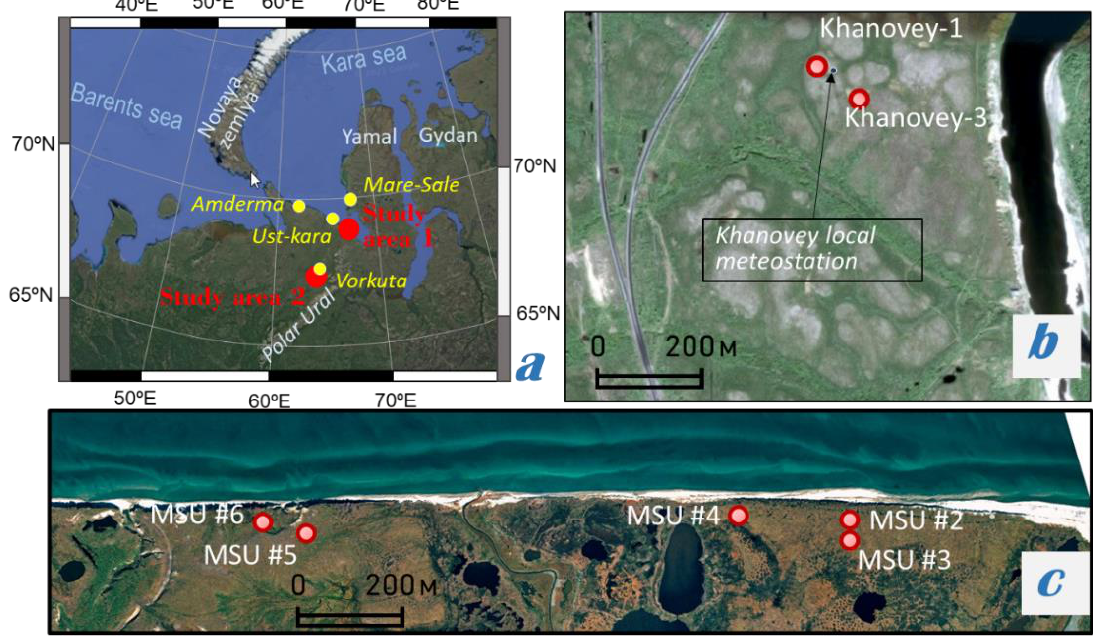
Figure 1. Location of the research area: ( a ) satellite image of Russian Arctic segment within Barents and Kara sea regions (from [28]) (meteorological stations — yellow circles); ( b ) satellite image of in the Khanovey area with boreholes (red circles); ( c ) satellite image of coastal zone in the Baydaratskaya Bay section with boreholes (red circles)